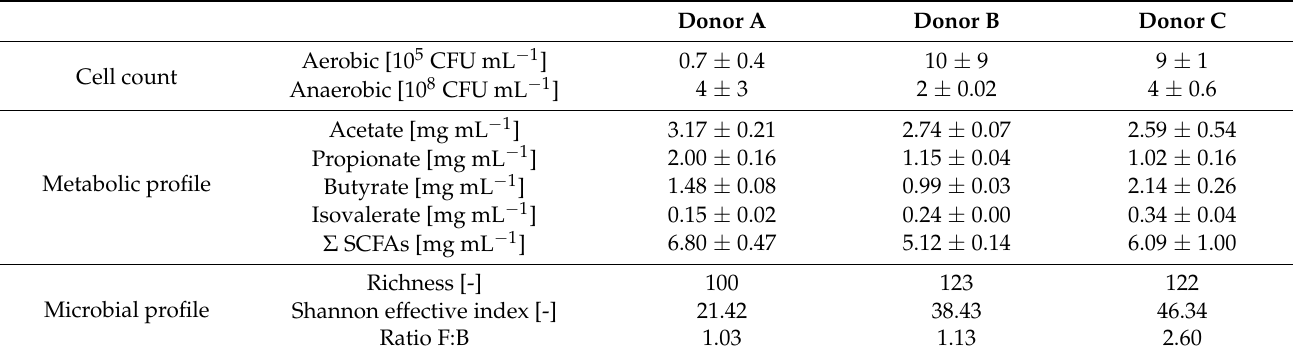
Table 2. Characterization of the three donors by cell count, metabolites as well as richness, Shannon effective index and the ratio between Firmicutes and Bacteroidetes. Donor A Donor B Donor